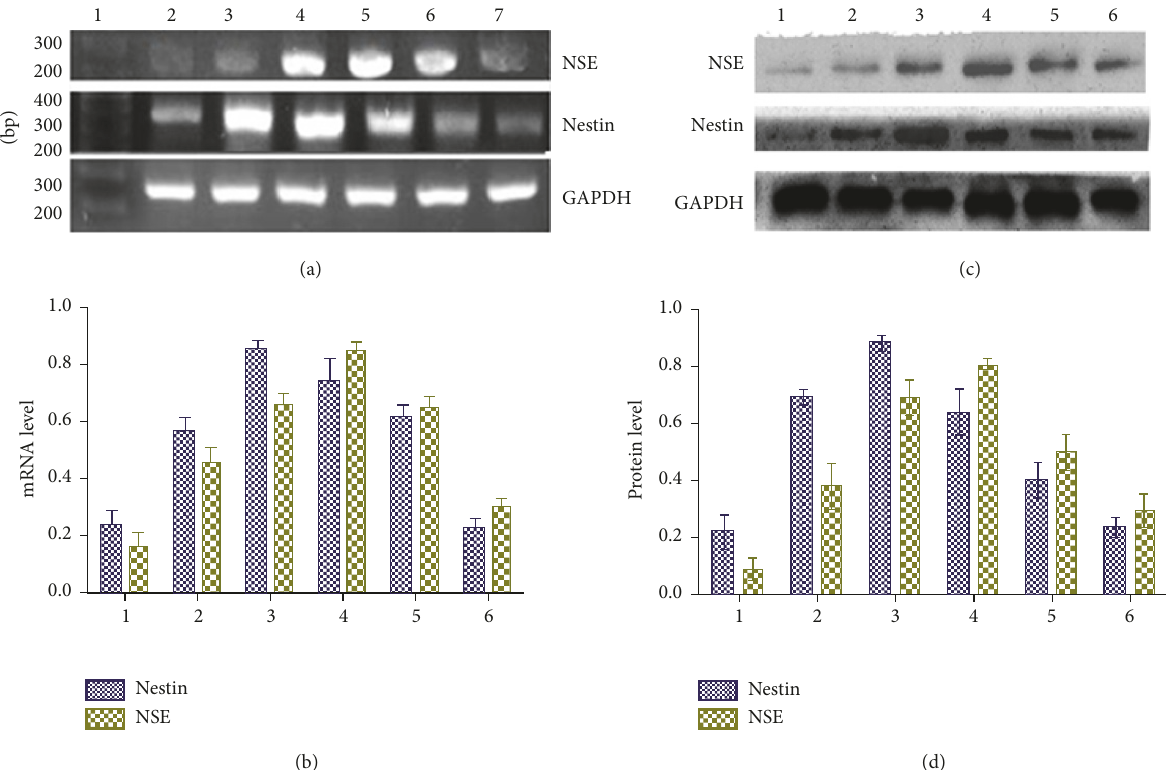
Figure 4: mRNA and protein levels of nestin and NSE in resveratrol-treated hUC-MSCs. (a) Original gel images and (b) summary data showing mRNA levels of nestin and NSE in resveratrol-treated hUC-MSCs at different time points. (c) Gel images and (d) summary data showing protein levels of nestin and NSE in resveratrol-treated hUC-MSCs at different time points. 1–6: period of resveratrol treatment for 0 (control), 2 h (3), 4h (4), 6 h (5), 12h (6), and 24 h